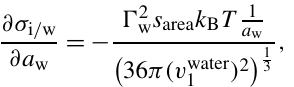
tions of σ i / w (T,a w ) (Ickes et al., 2015). Instead, we use